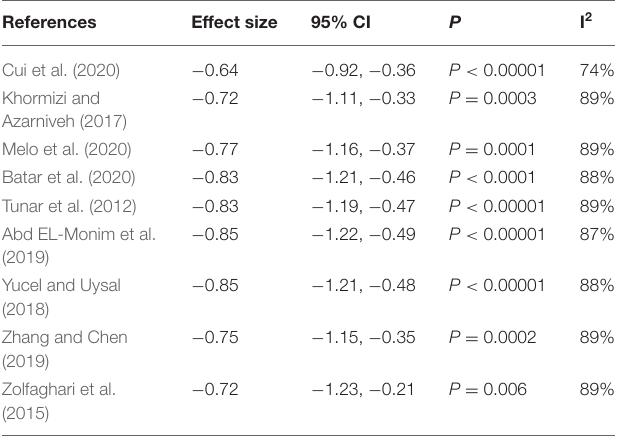
TABLE 2 | Sensitivity analysis for HbA1c.